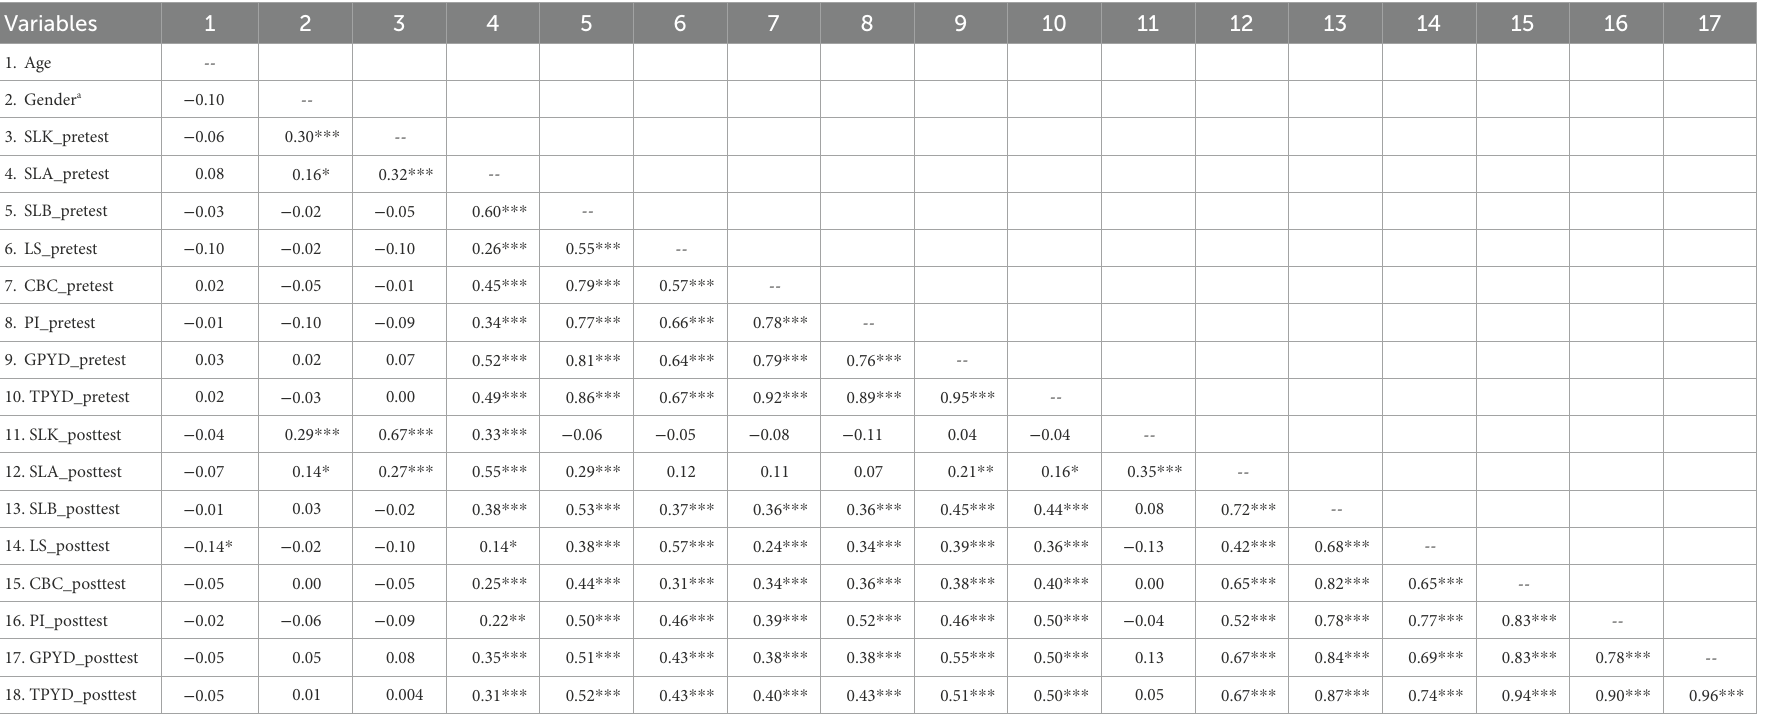
TABLE 2 Correlations between